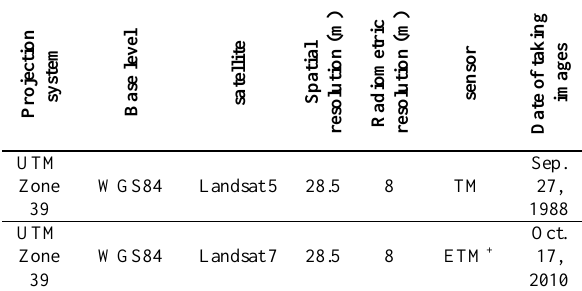
Table (2): characteristics of the obtained images for